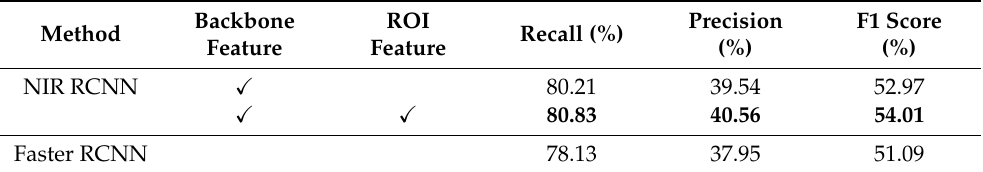
Table 5. Performance comparison with NIR RCNN and Faster RCNN with score threshold = 0.2 in our constructed dataset, where “ (cid:88) ” denotes fusion operation.